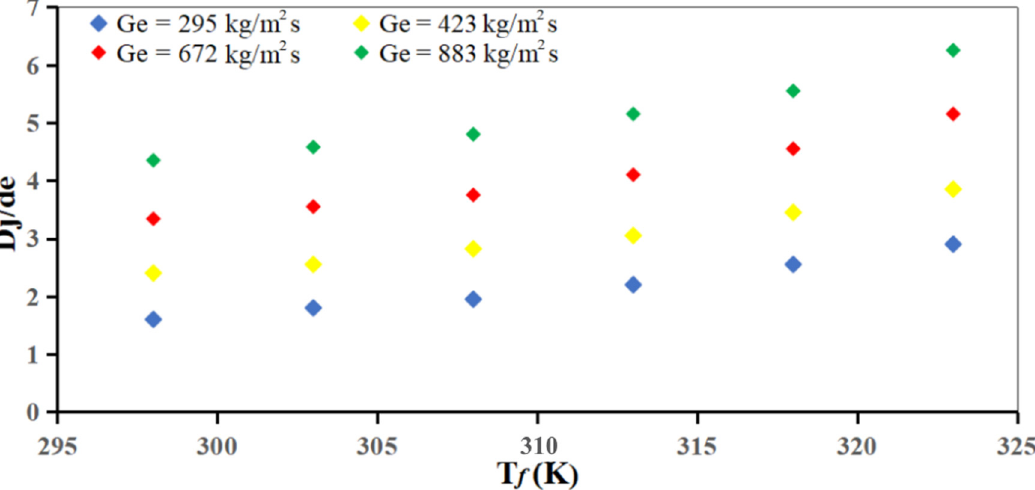
Figure 3. Relationship of the steam jet length to the nozzle exit diameter as a function of the subcooled water temperature.